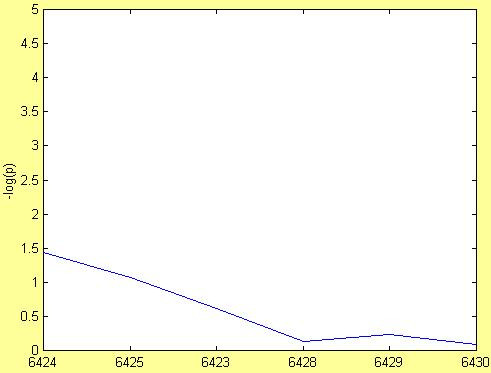
The transformed p-values of multiplicative SWEPT statistic using p-value data in Example 4.